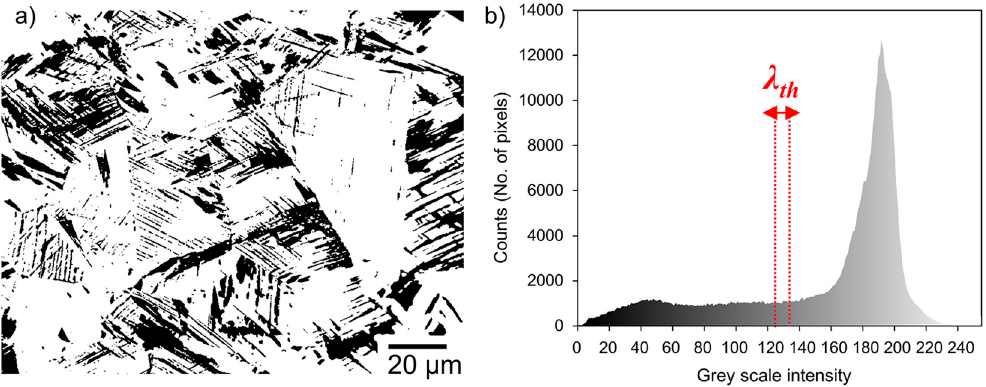
Figure 4. ( a ) Black-and-white image obtained from the light-optical micrograph of the condition strained up to ε E = 0.10 after applying a grey scale threshold value λ th = 127; ( b ) Histogram of the same micrograph showing the number of pixels vs. the grey scale intensity value.